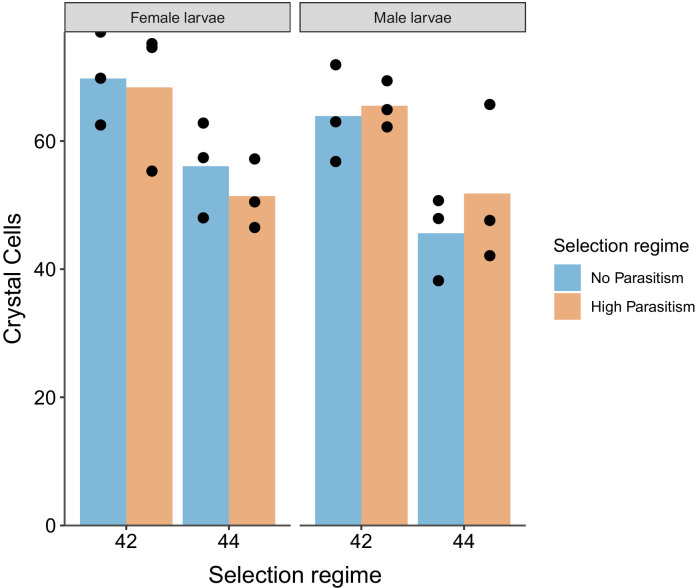
Sessile crystal cells numbers.Number of sessile crystal cells in dorsal side of the A7 abdominal segment of larvae in male and female larvae. Dots represent the average number of crystal cells calculated from 10 larvae of each triplicate population from both selection regimes. Bar heights represent the average of each selection regime, no parasitism (blue) and high parasitism (Orange).Figure 5—figure supplement 6—source data 1.Sessile crystal cell numbers.